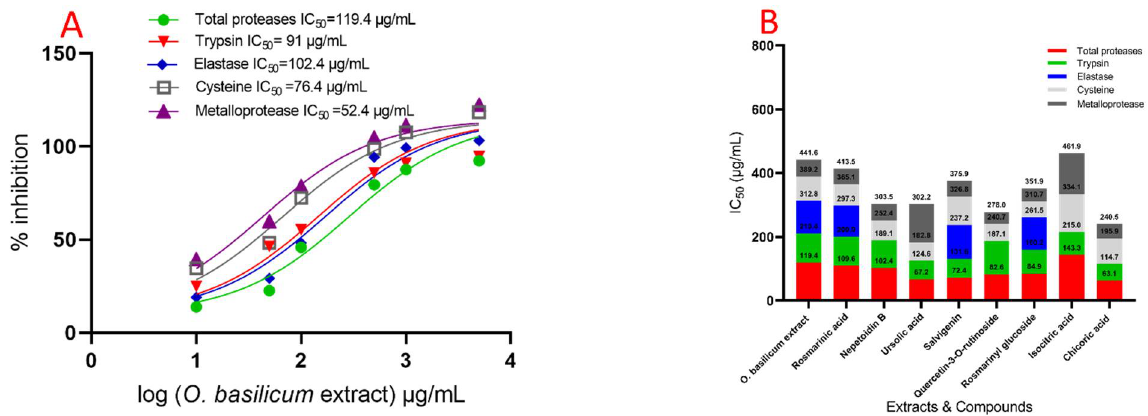
Figure 3. IC 50 of O. basilicum extract from cell suspensions and rosmarinic acid, nepetoidin B, ursolic acid, salvigenin, quercetin-3-O-rutinoside, rosmarinyl glucoside, isocitric acid, and chicoric acid against total proteases, trypsin-like serine proteinase, chymotrypsin-like serine proteinase, elastase, cysteine protease, and metalloprotease (in vitro) of R. ferrugineus midgut, ( A ) activity, with IC 50 of O. basilicum extract against proteases enzymes (in vitro), and ( B ) IC 50 of O. basilicum extract and compounds against proteases’ enzymes (in vitro), according to one-way analysis of variance on the enzyme activity data